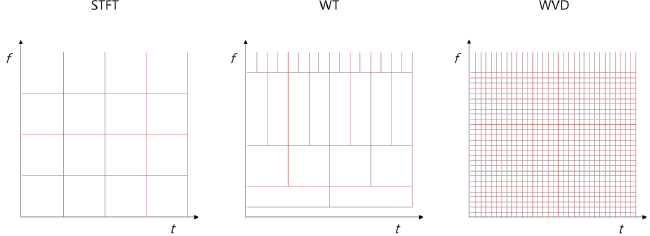
Figure 12. Diagram of the resolution of methods.